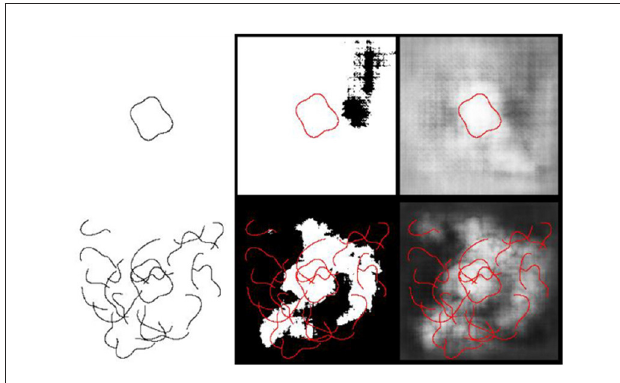
FIGURE7 “Inside/Outside” classification of sample images following unrestricted transfer learning in Experiment 2. (Left column) Two sample input stimuli are shown, including an isolated closed contour (left, top) and the same contour presented among contour fragments, replicating training conditions (left, bottom) . In both cases, correct classification of the image was “Inside” only if the probe dot (not shown) was presented within the closed contour. (Middle column) Model classification results are shown as binary images indicating the model’s classification for various positions of the probe, with the input stimulus superimposed (in red). White indicates probe positions classified as “Inside;” black indicates probe positions classified as “Outside.” (Right column) The same results are shown in the right column, but with p (inside) indicated by grayscale values (black = 0.0, white =